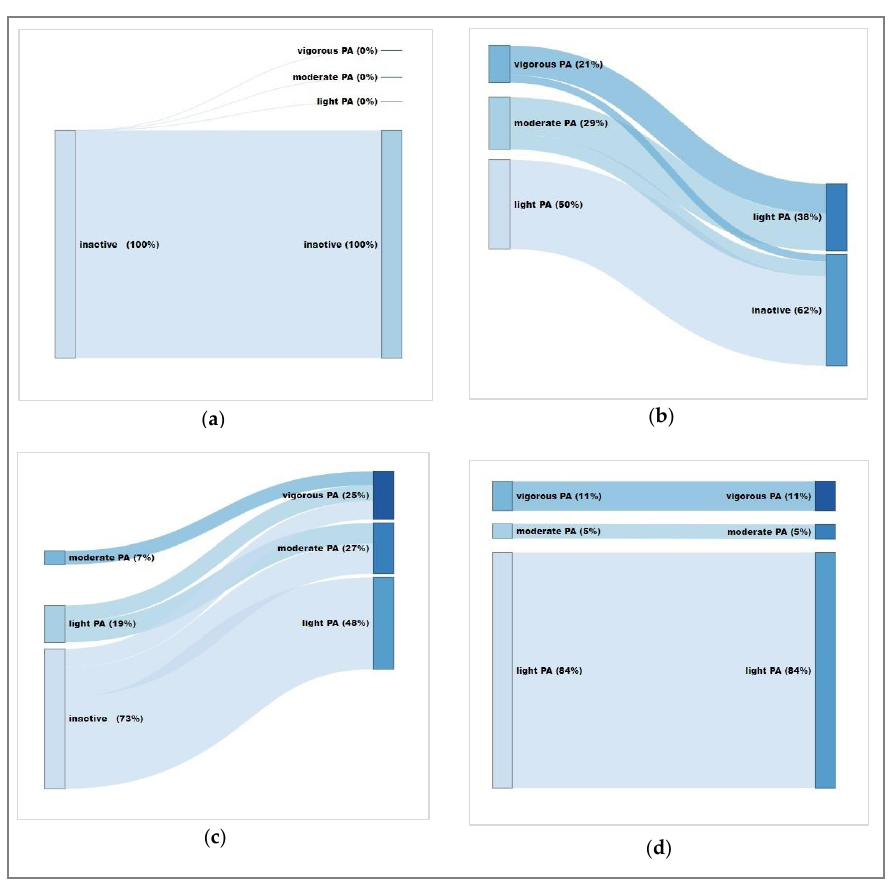
Figure 2. Weekly activity levels from baseline to follow-up for the ( a ) inactive (23.7%), ( b ) decreasing (12.2%), ( c ) increasing (42.1%), and ( d ) stable active (19.3%) trajectories. Inactive: no activity; light PA: < 150 min / week; moderate PA: 150- < 300 min / week; high PA: ≥ 300 min / week. Software: displayr.com (Displayr, Sydney, Australia).